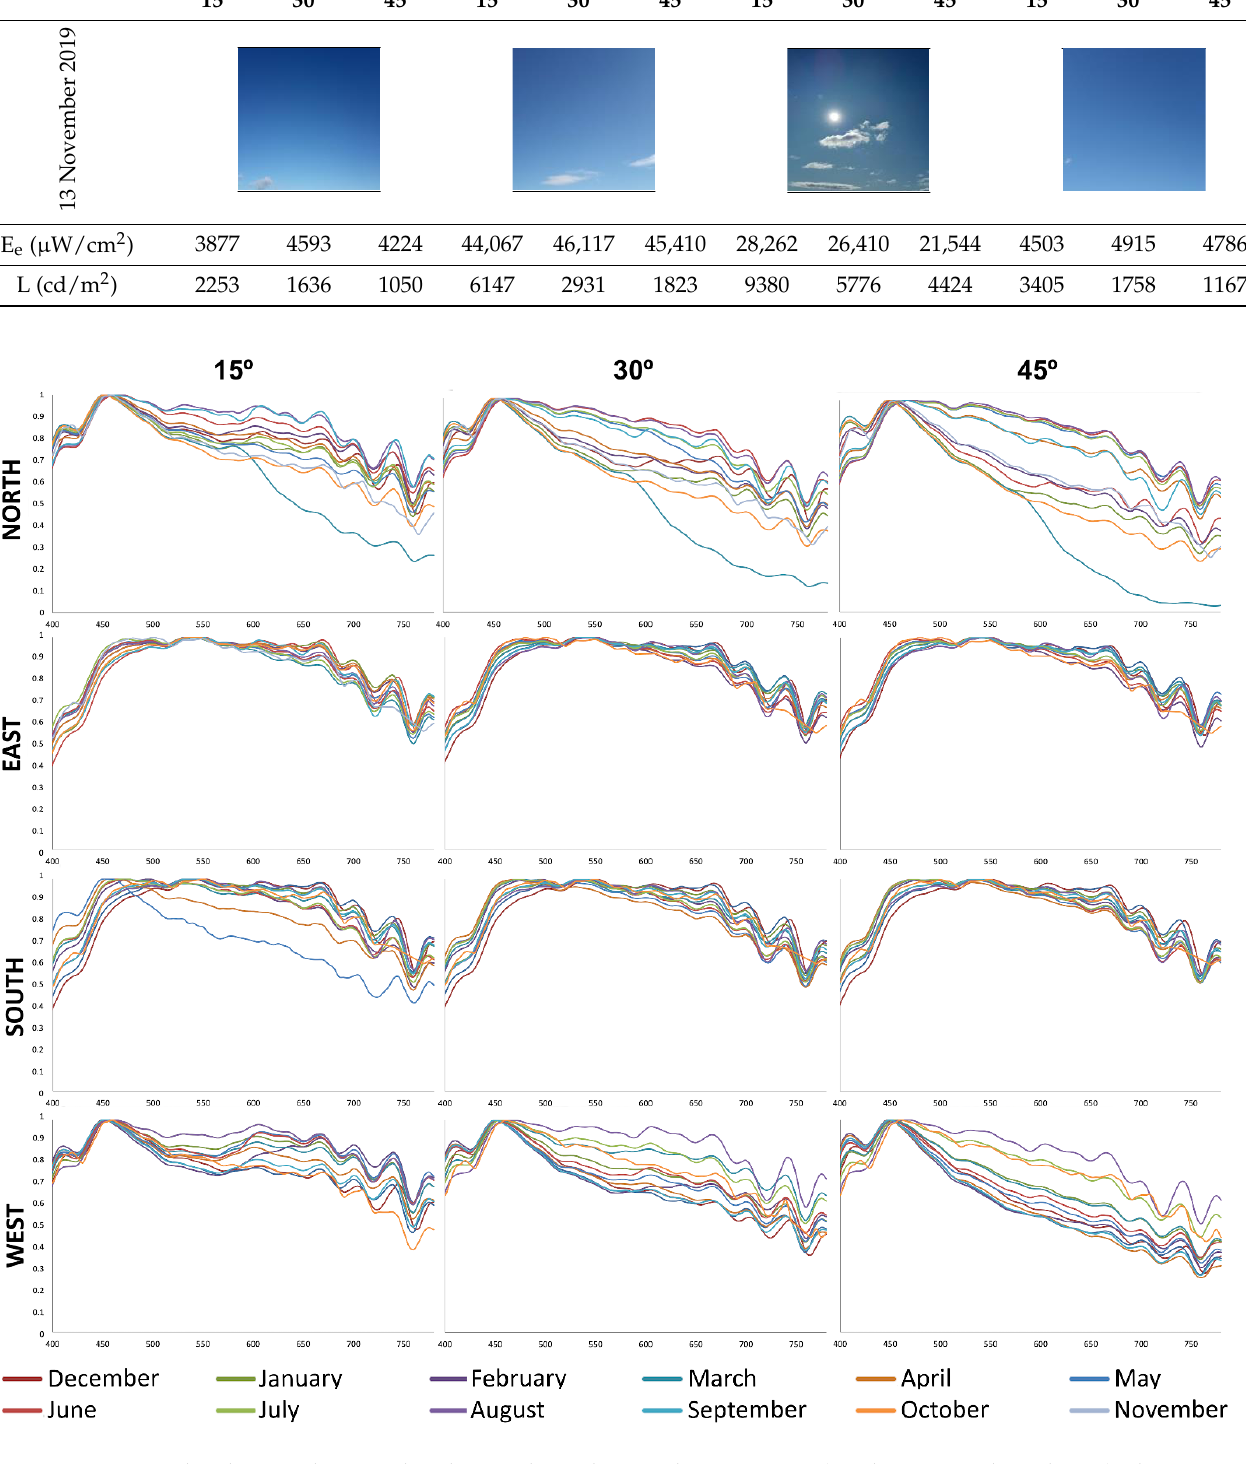
Figure 1. Normalized spectral power distribution depending on the orientation (north, east, south, and west), elevation (15°, 30°, and 45°) and seasonality.